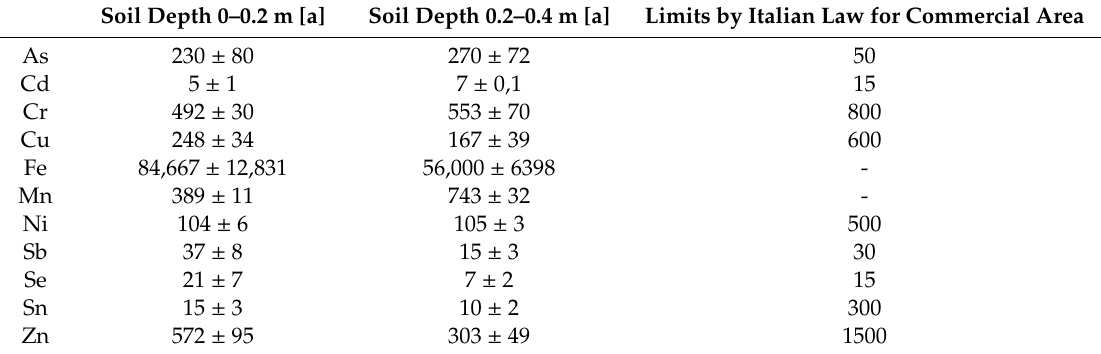
Table 2. Average concentration (mg / kg) of heavy metals in the soil at two depth sampling points in the study area. Number of replicas 18. [a] mean ± SE.